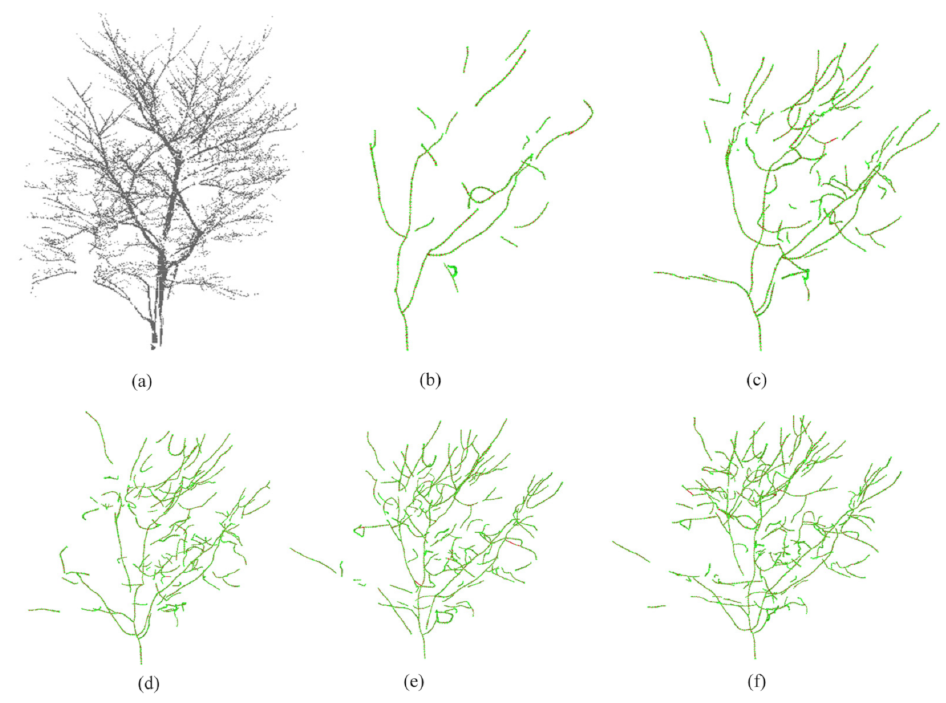
Figure 4. L 1 -Median initial skeleton points extracted at different sampling points. ( a ) Initial point clouds; ( b ) N –5%; ( c ) N –10%; ( d ) N –15%; ( e ) N –20%; ( f ) N –25%.